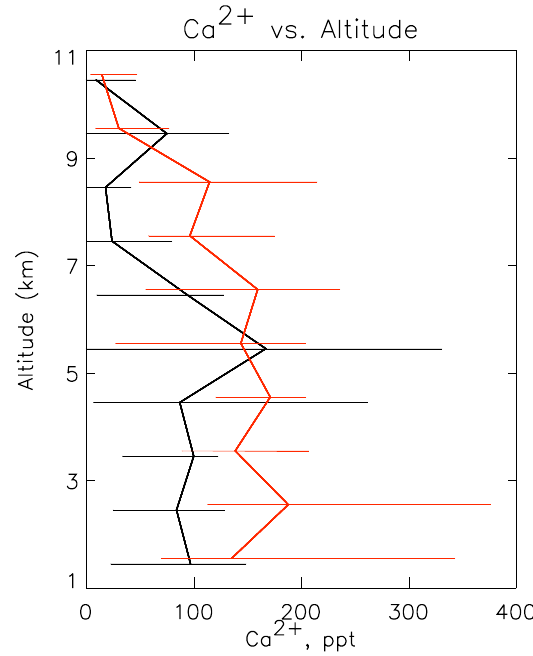
Fig. 3. Altitude distribution of observed (black) and simulated (red) Ca 2 + concentrations during INTEX-B. The data are binned in 1km vertical intervals. Profiles show median values in each bin. Whiskers span 50% of the data in each